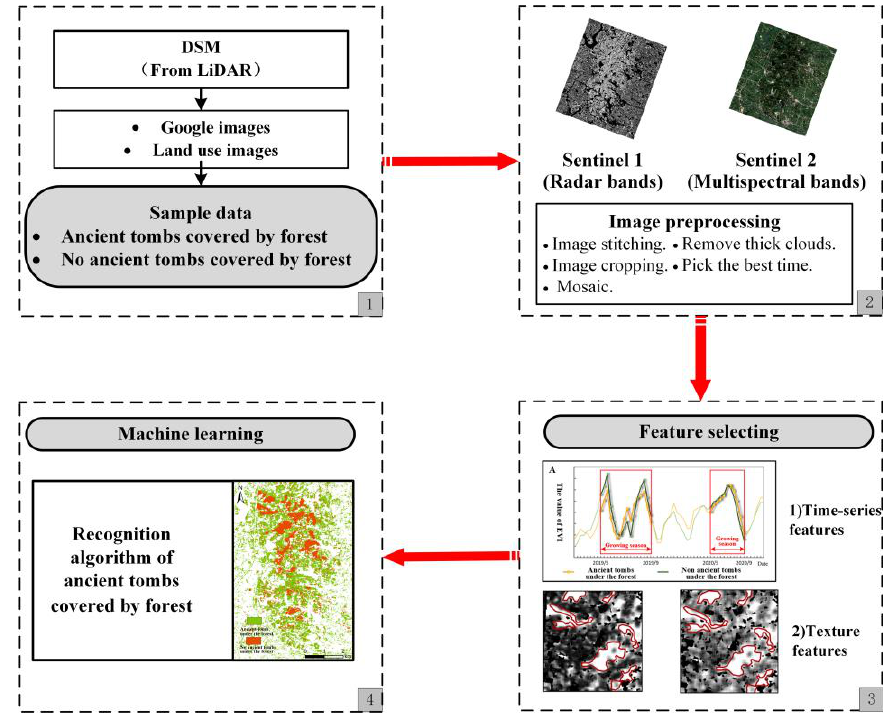
Figure 2. Overview of